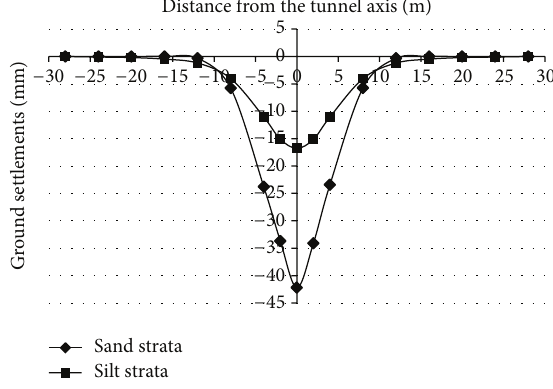
Figure 9: Relationship curve between the supporting pressure ratio and the maximum horizontal displacement of the tunnel face. Note: a negative value indicates thedeformation towards insidethetunnel; a positive value indicates the compressional deformation in front of the tunnel face.